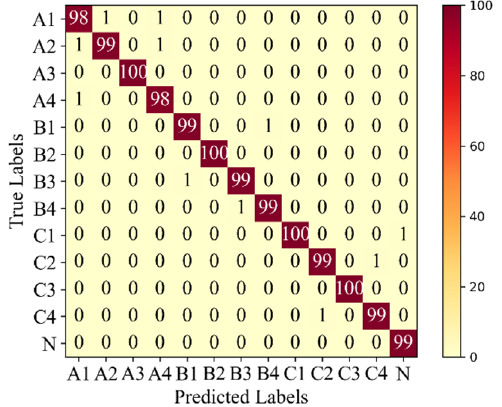
Figure 25. Confusion matrix of the LEG Transformer.